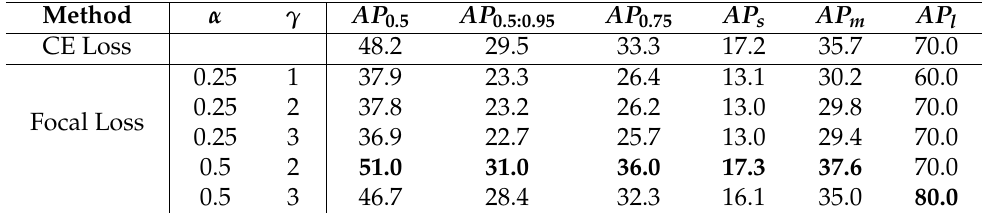
Table 1. Comparison of different γ / α settings on Pest24 validation set.